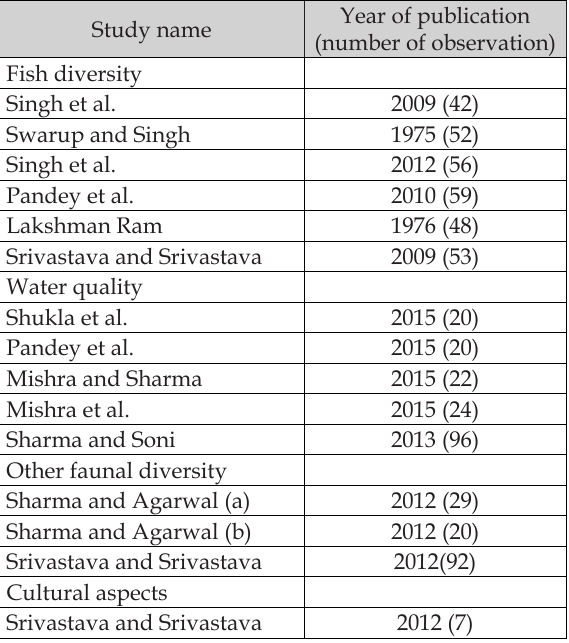
Table 4. list of literature included for CMA. Table 3. Explanatory indicators for willingness to